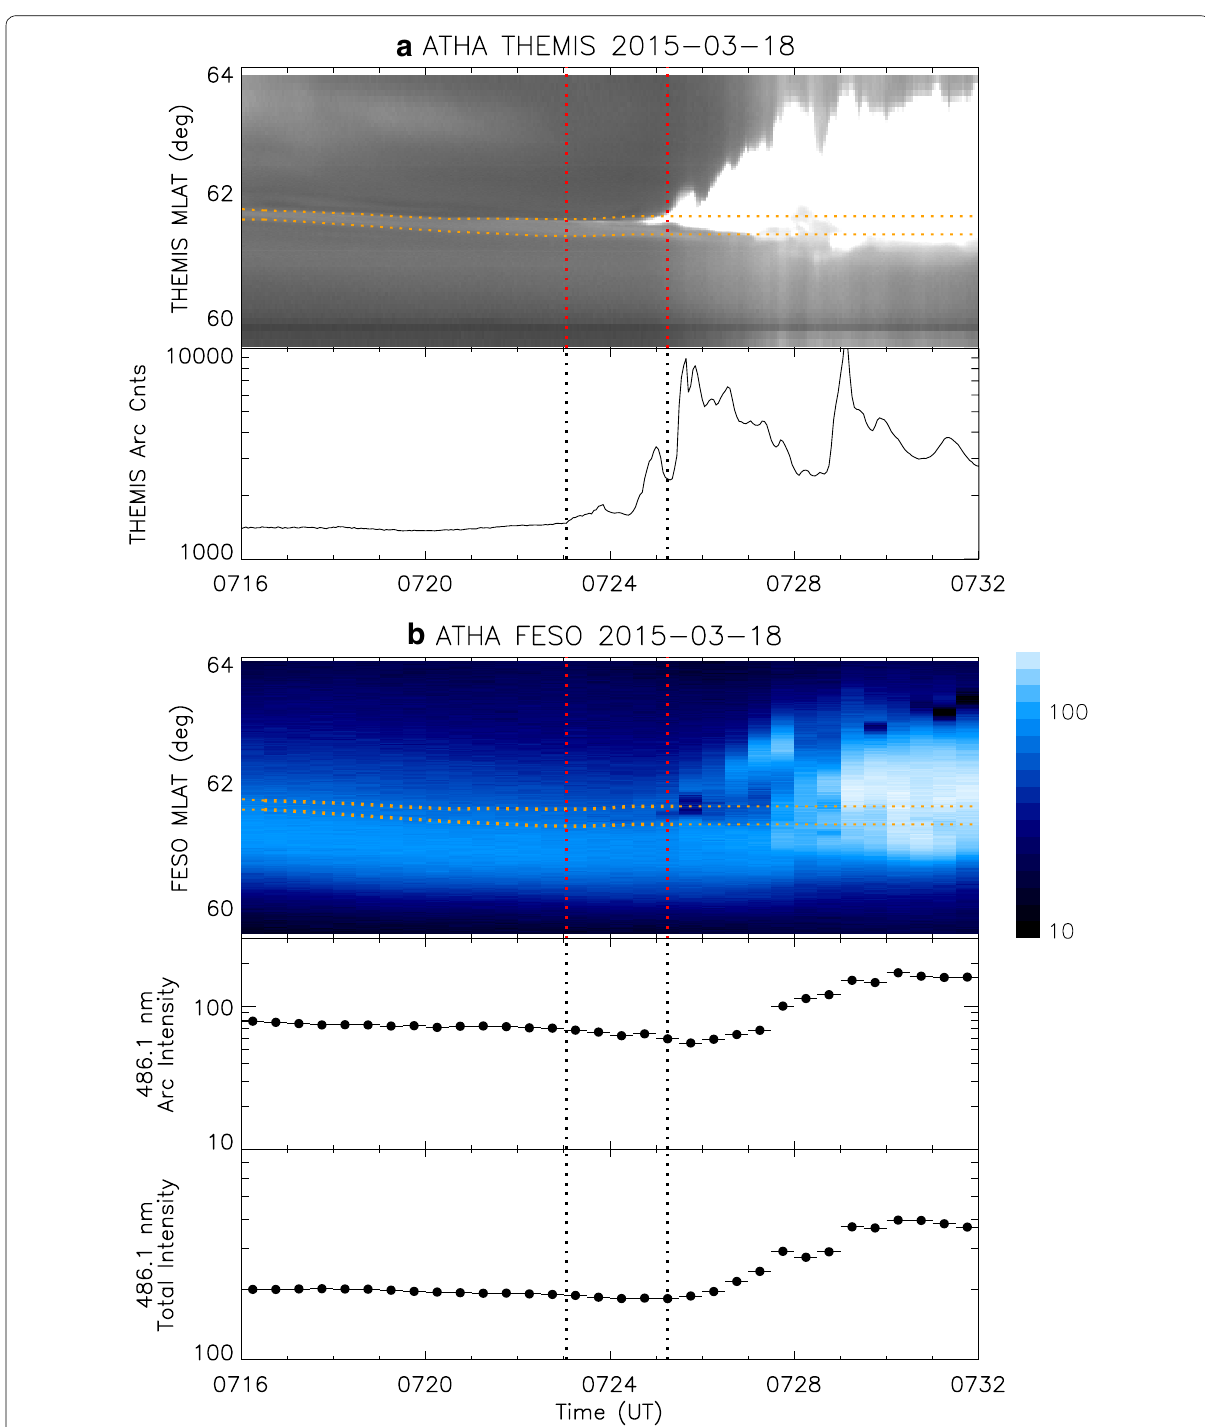
Fig. 5 THEMIS ASI observations and FESO proton auroral observations. Top panel of a shows the THEMIS ASI keogram constructed along the FESO scan meridian. The arc band is shown in orange dotted lines. The lower panel of Fig. 2a shows the ASI counts sampled and averaged over the arc band along the FESO meridian. In Fig. 2b, the top panel shows the FESO 486.1 nm proton auroral intensities versus time and latitude, with the arc band overploted. The 2nd and bottom panel of b show the proton auroral intensities averaged over the arc band, and the total proton auroral intensities integrated over full FESO latitudes, respectively. The scan time (30 s) of each FESO data point is marked by a horizontal bar. Two vertical dotted line throughout the plot denote T 0 and T 1, the TSSO